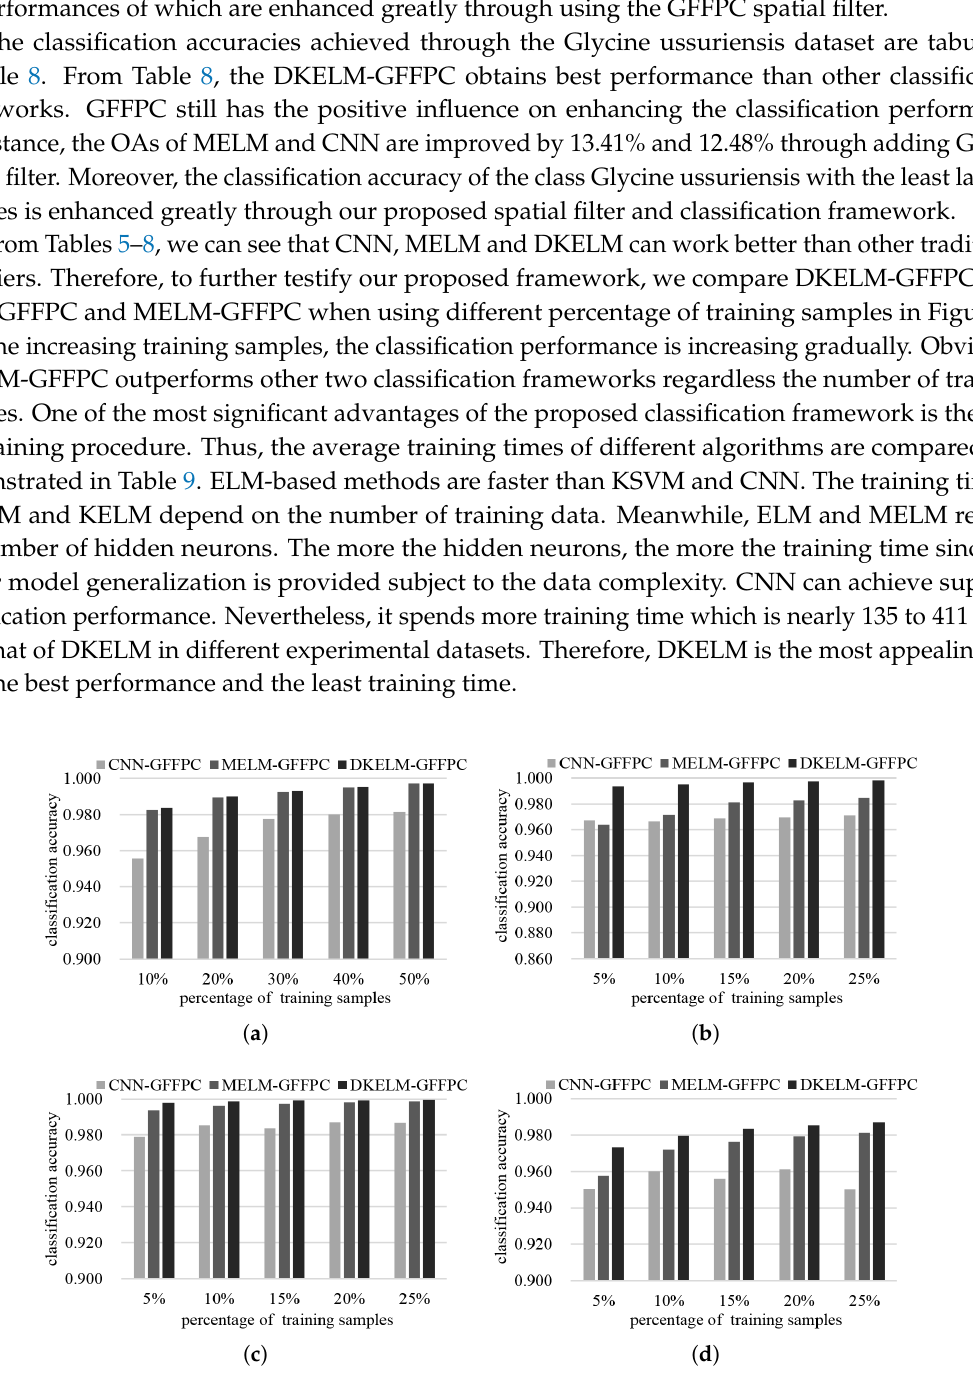
Figure 14. The performance of CNN, MELM and DKELM combined with GFFPC through using different size of training sample in ( a ) Indian pines, ( b ) University of Pavia, ( c ) Salinas, and ( d ) Glycine ussuriensis